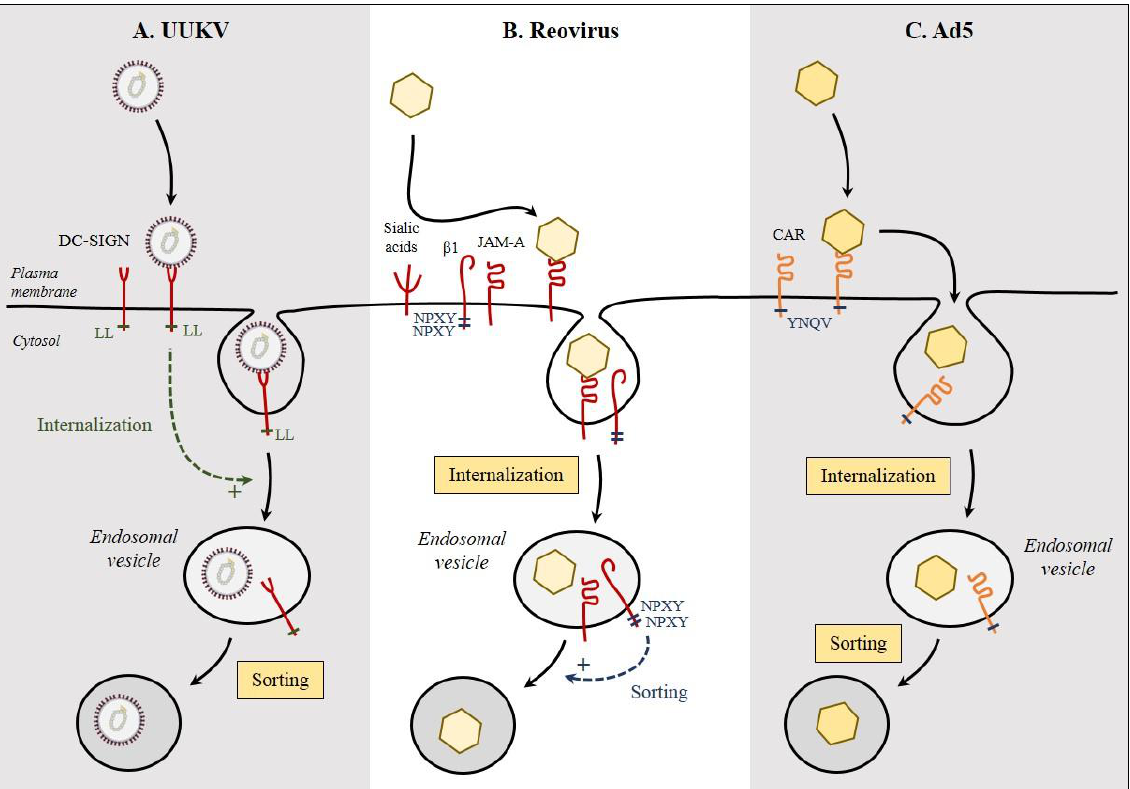
Figure 4. Endocytic signals in virus receptors. Relatively few endocytic signals in receptors have been assessed for their role in virus entry and infection. ( A ) The LL motif of DC-SIGN is critical for Uukuniemi virus (UUKV) internalization and acts as endocytic motif; ( B ) The two NPXY motifs in the β 1-integrin ( β 1) seem to act as sorting motifs to direct reovirus into the right endosomal compartment; ( C ) No function has been attributed to the YNQV motif in CAR regarding infection by adenovirus 5 (Ad5).